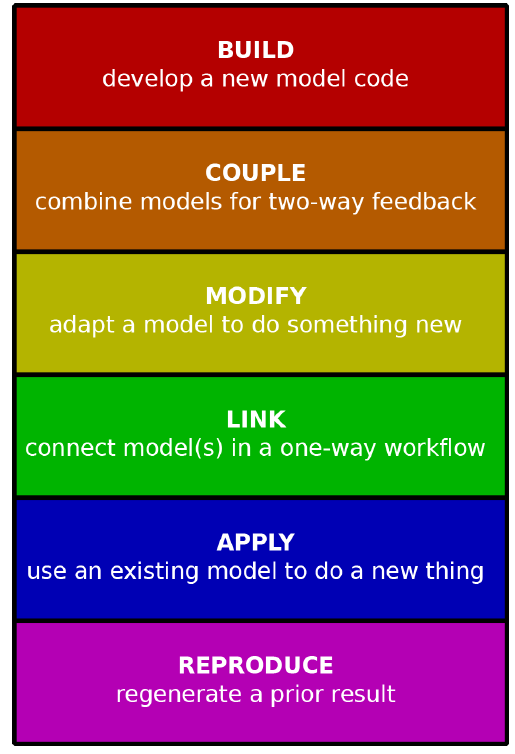
Figure 2. Taxonomy of model operation tasks. Tasks are listed in (approximately) increasing order of complexity from bottom to